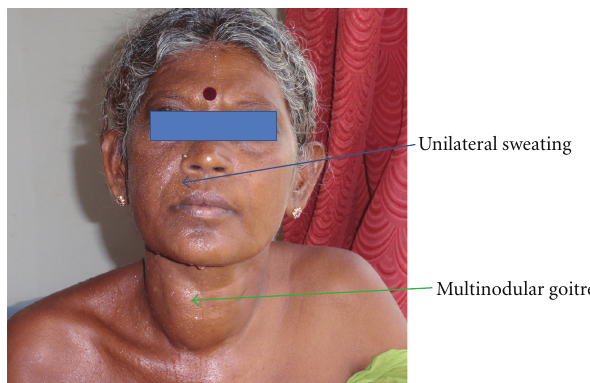
Figure 1: It reveals the unilateral nature of sweating and the multin- odular goitre.